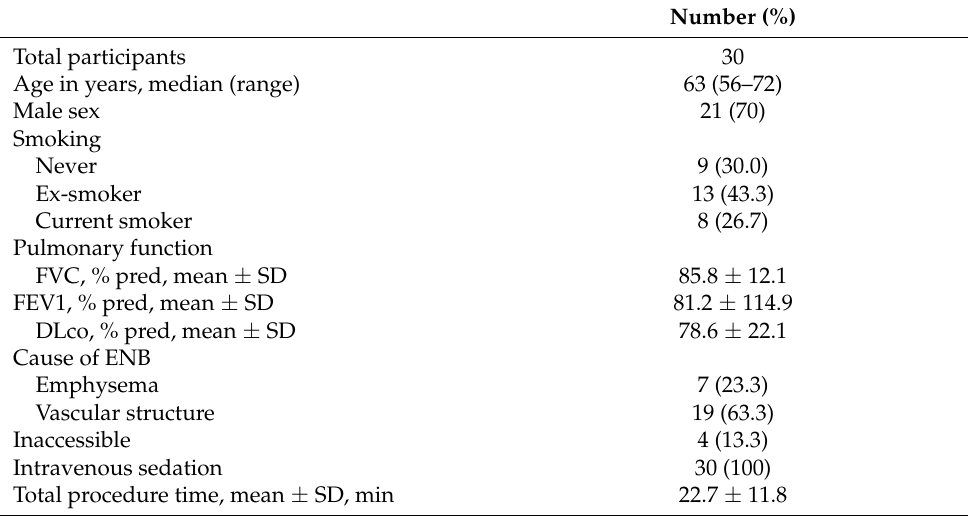
Table 1. Baseline characteristics of the study participants.